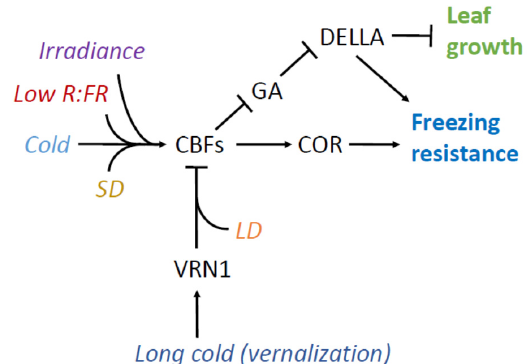
Figure 3. Putative model showing the central role of CBF transcription factors in coordinating freezing resistance and leaf growth in response to temperature and light. Cold induces expression of CBFs , which are important in the development of freezing resistance through the induction of the CBF regulon of cold-induced genes (here collectively indicated with COR ), and also play a role in down-regulation leaf growth via gibberellic acid (GA). Short days (SD), irradiance, and low red to far red light-ratio (R:FR), can take part in the induction of CBFs . Prolonged cold leads to a gradual increase in VRN1 transcripts. VRN1 can down-regulate CBFs and freezing resistance, particularly in long days (LD). In temperate grasses there are around 20 CBF genes which are likely to have partly differentiated roles.